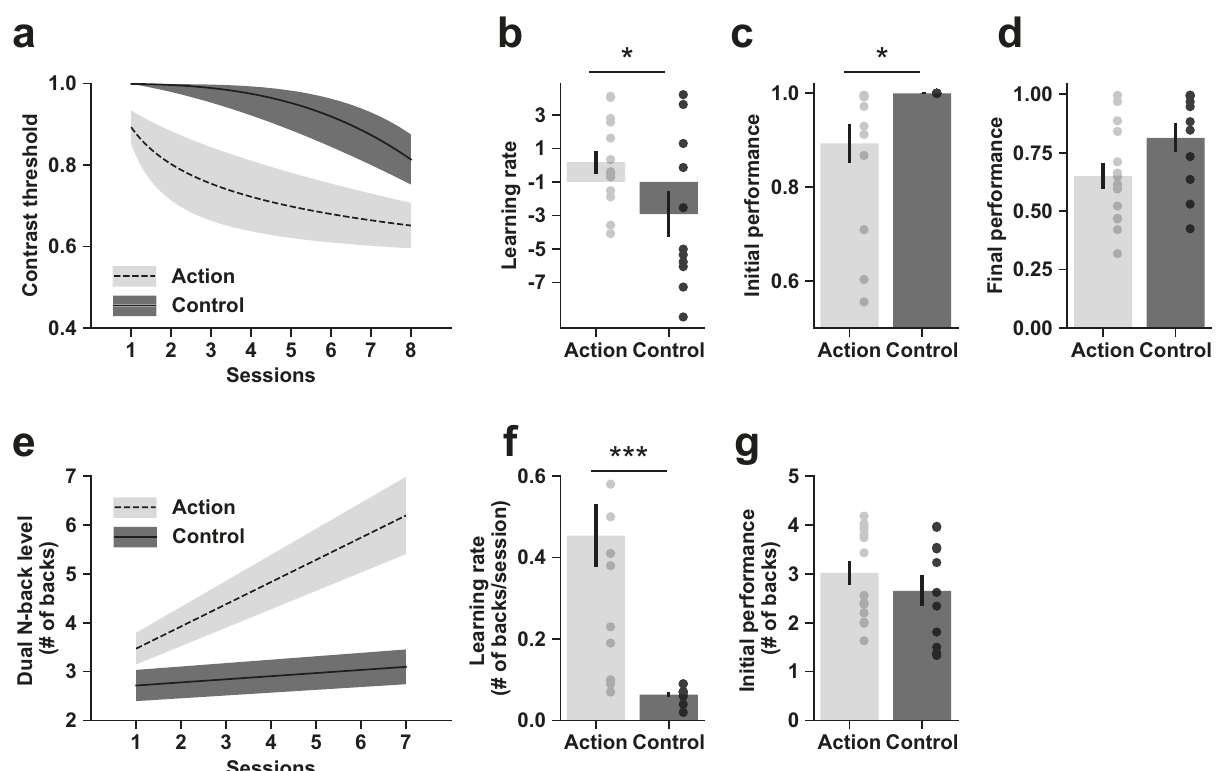
Fig. 2 Action video game training produces “ learning to learn ” . ( a ) shows the impact of video game training on the orientation learning task (lower contrast thresholds represent better performance), while ( e ) shows the impact of video game training on the working memory learning task (higher N -back levels represent better performance). In ( a , e ), the dashed and solid lines are learning curves plotted using the group averaged estimated parameters (i.e., b – d , f , g ). The upper and lower bounds of the shaded area are learning curves plotted using the values of the group mean ± S.E.M. The same conventions are used in Fig. 3 and Fig. S1. Estimated learning parameters in the orientation learning task ( b – d) and the working memory learning task ( f – g ) con fi rm higher learning rates ( b , f) in the action video game trainees compared with the control video game trainees. Note that the learning rates in the orientation learning task are plotted against the baseline of − 1 instead of 0 because − 1 indicates a linear learning progression (see Fig. 1c). Values varying from − 1 to + in fi nity (or -in fi nity) indicate faster (respectively, slower) learning. All error bars are S.E.M. across participants. Signi fi cance conventions are * p < 0.05; ** p < 0.01; *** p < 0.001. Black and gray circles correspond to each participant individual data. These conventions are kept for all fi gures in this